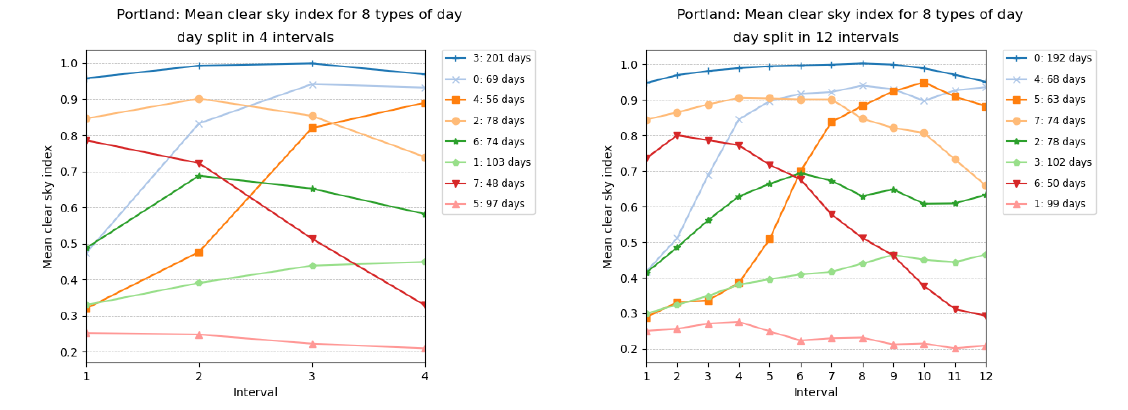
Figure 4. Types of days for